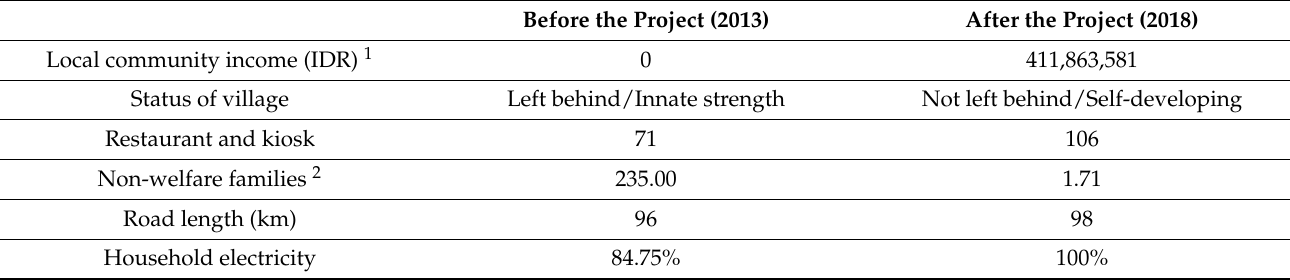
Table 5. Changes in Mertak Village’s